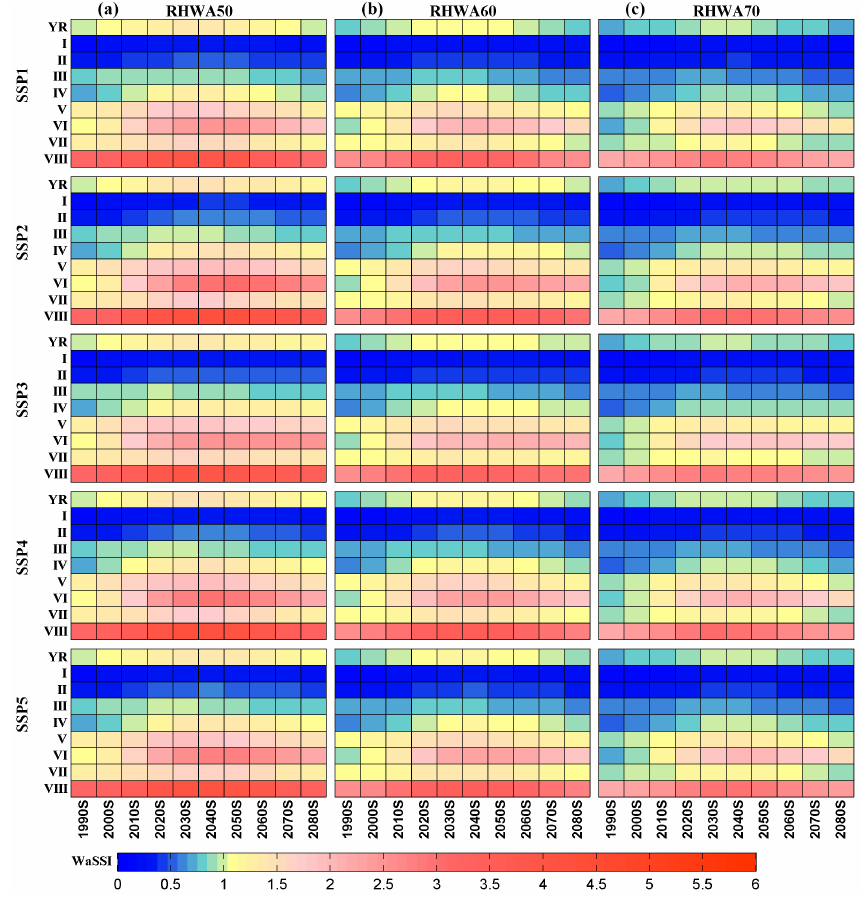
Figure 5. Average annual water supply stress index (WaSSI) for the YR basin and eight sub-basins throughout the 21st century under five different SSPs. Water supply was estimated with an RHWA value of 50, 60, and 70% in the left, center, and right column, respectively. The WaSSI is calculated for each decade. Water scarcity occurs in a given basin if WaSSI is greater than